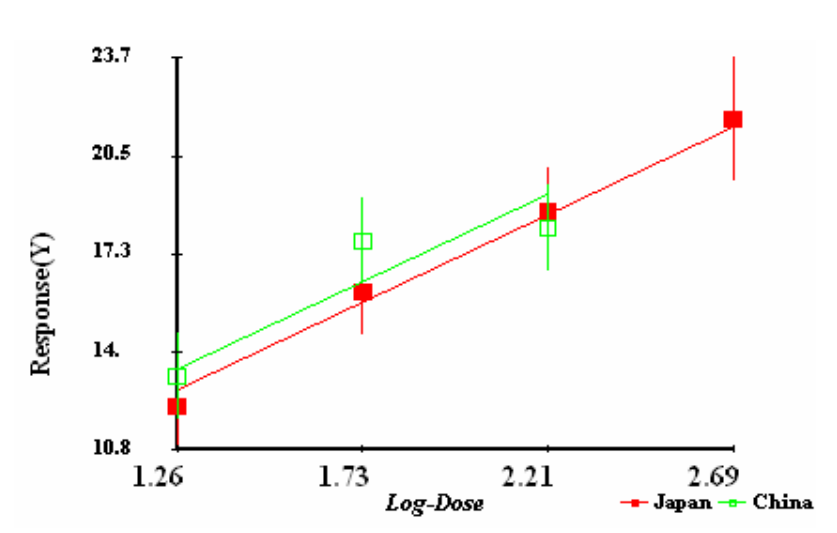
Figure 4: Graphical analysis of the neutralization of Jiangzhe Agkistrodon halys venom by one unit of antihemorrhagic activity (1U) of Agkistrodon halys (Japan) and Jiangzhe Agkistrodon halys (China)